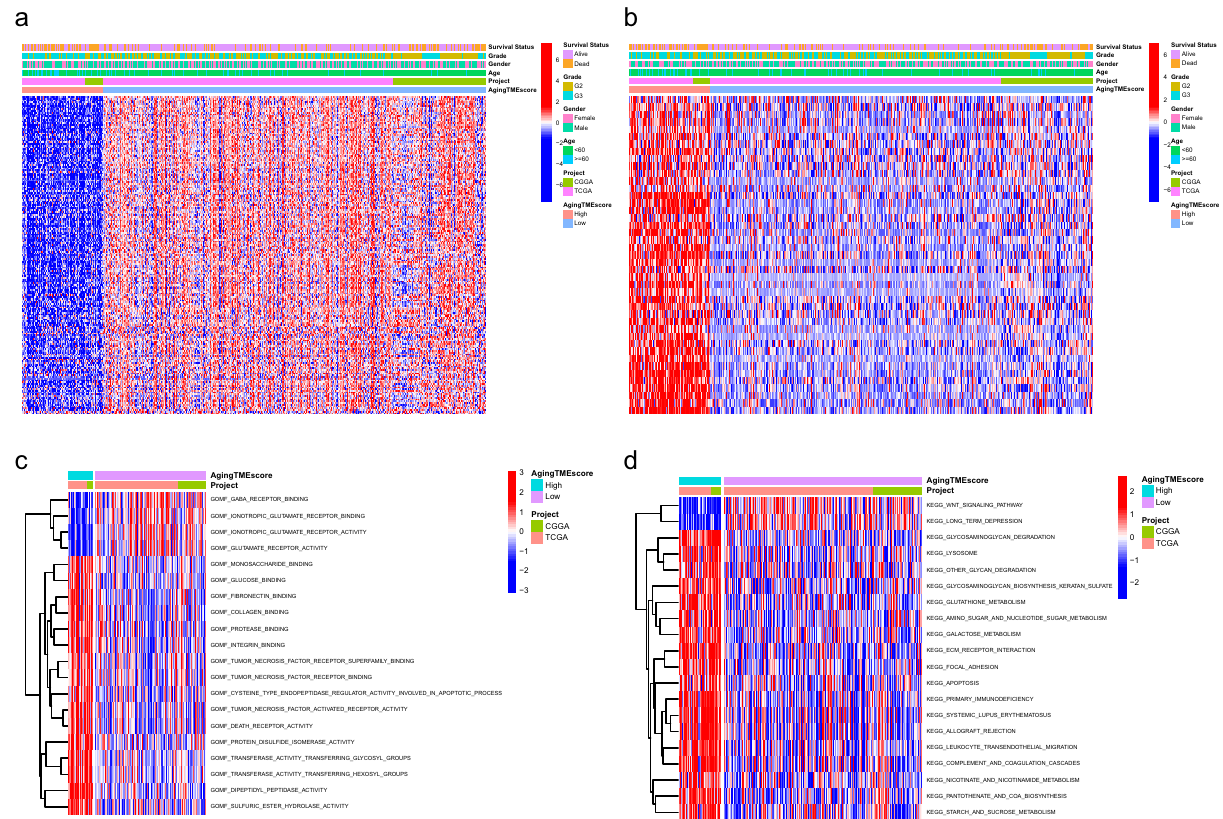
Figure 5. Functional enrichment analysis between the low and high aging TME score groups. ( a ) The expression patterns of favorable ATMERS between groups. ( b ) The expression patterns of unfavorable ATMERS between groups. ( c ) The enrichment analysis of GO molecular functions between groups. ( d ) The enrichment analysis of KEGG pathways between groups. TME, tumor microenvironment; ATMERS, aging tumor microenvironment related signature; GO, Gene Ontology; KEGG, Kyoto Encyclopedia of Genes and